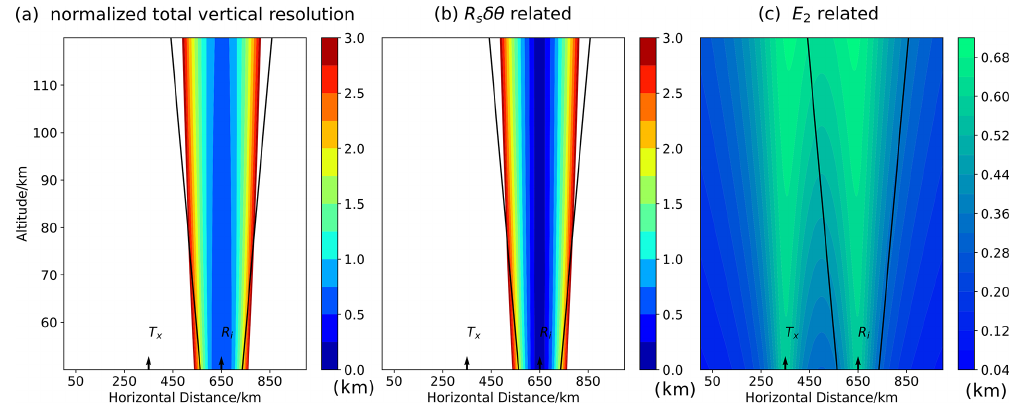
Figure 6. The normalized vertical resolution distribution in a vertical section from 50 to 120km height when the error term “ δR s ” is ignored. Panels (a–c) are the total, R s δθ -related and E 2 -related normalized resolution distributions, respectively. These results are the same as those produced in Hocking’s work (Hocking, 2018). The two black arrows represent the positions right above the transmitter (Tx) and the receiver (Rx) and the transmitter–receiver separation is 300km. The region between the two oblique black lines is the sampling volume for the receiving array because the elevation angle is beyond 30 ◦ to reduce influence from potential mutual antenna coupling or from other obstacles in the surrounding area. Except the region at large elevation angles (i.e., 90 ◦ ), the E 2 -related resolution values are much lower than the R s δθ - related errors. The R s δθ -related resolution distribution only depends on the receiving antennas. Thus, the total vertical resolution distribution is nearly unchanged with the variation of the transmitter–receiver distance. Normalized resolution values that exceed 3km (which correspond 12km vertical resolution) are not